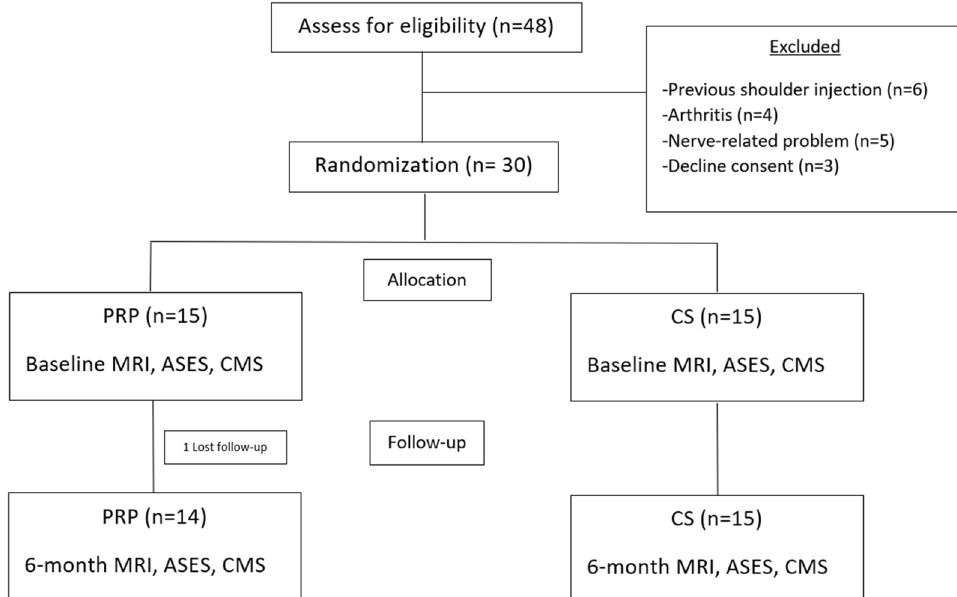
Fig. 1 Consolidated Standards of Reporting Trials (CONSORT) diagram. PRP, platelet-rich plasma; CS, corticosteroid; ASES, American Shoulder and Elbow Surgeons Shoulder score; CMS, Constant–Murley